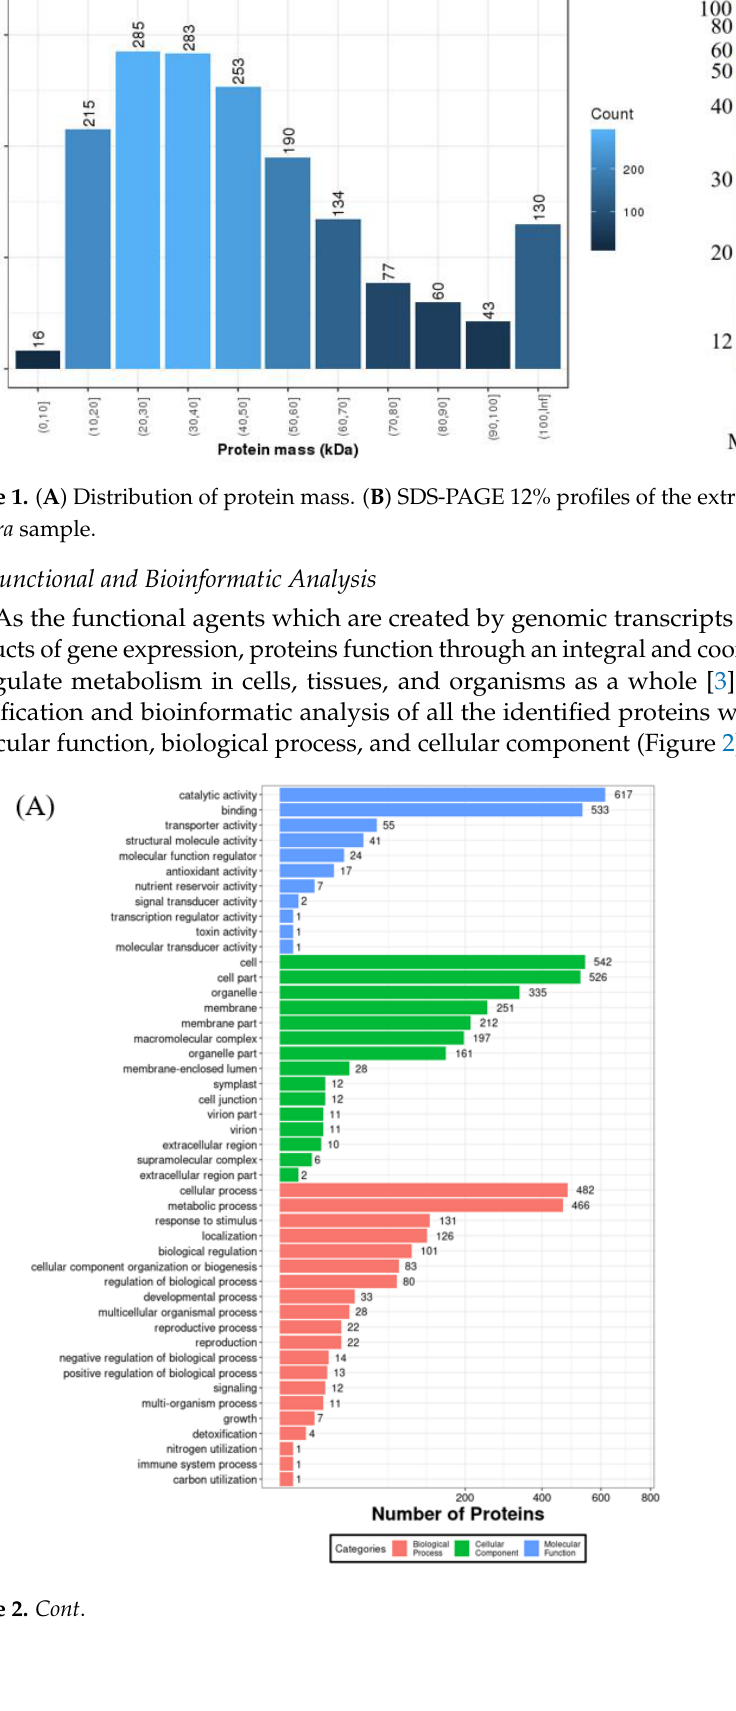
Figure 2. ( A ) Gene ontology (GO) term enrichment for coconut derived proteins. ( B ) Bar chart of the Eukaryotic orthologous group (KOG) analysis. 2.2.1. Molecular Functions As shown in Figure 2A, the results of molecular functional analyses demonstrated that the proteins with catalytic (36.6%) and binding (31.6%) activities were predominant in these groups. The exuberant metabolism and biosynthesis in the coconut endosperm need various proteins with different catalytic activities. Therefore, proteins represent the catalytic activities in various aspects, such as hydrolase activity, transferase activity, and phosphatase activity. Multiple studies have analyzed the individual enzymatic functions of coconut proteins during seed development, such as the tyrosine kinase activity [20,21], polyphenol oxidase activity [22], and lipase activity [23]. For fruit development, coconut meat is imbued with various nutrients, such as minerals and bioactive molecules, so a mass of proteins with binding abilities is needed.